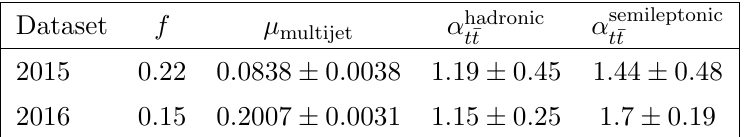
Table 1. The (cid:12)tted values of the normalization parameters (cid:22) multijet and (cid:11) of both t (cid:22) t samples and their statistical uncertainties, given for the two datasets. The per-jet transfer factor f is also listed, and is explained in section 5.2.1.